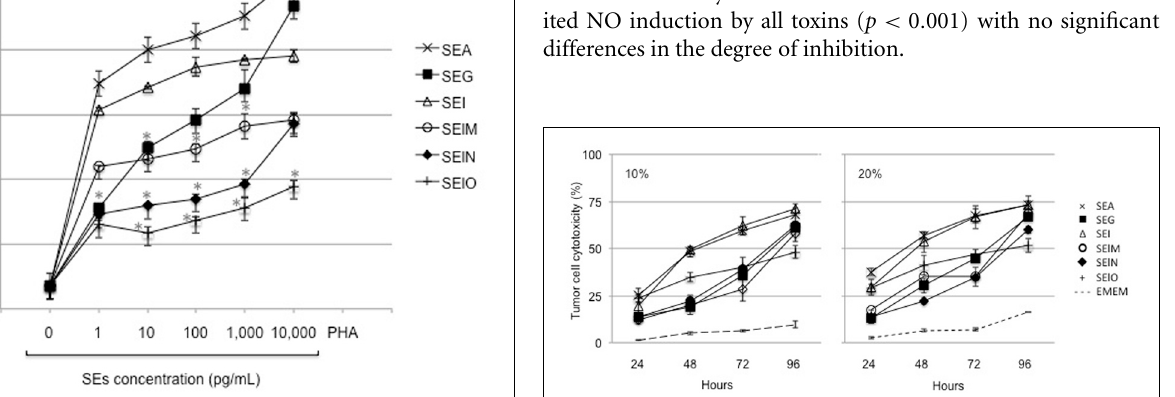
FIGURE 1 | Expression of early T cell surface marker CD69 after incubation of human PBMCs with SEA and egcSEs. CD69 expression was measured on T lymphocytes (CD3 + ) after 24h of incubation with PBMCs (10 6 cells/mL) in presence of SEA, SEG, SEI, SElM, SElN, or SElO (0–10ng/mL). PHA (100 μ g/mL) was used as positive control. Results are shown as the mean ± SEM for each point ( n = 3 independent experiments). Asterisks indicate statistical significance compared to SEA.